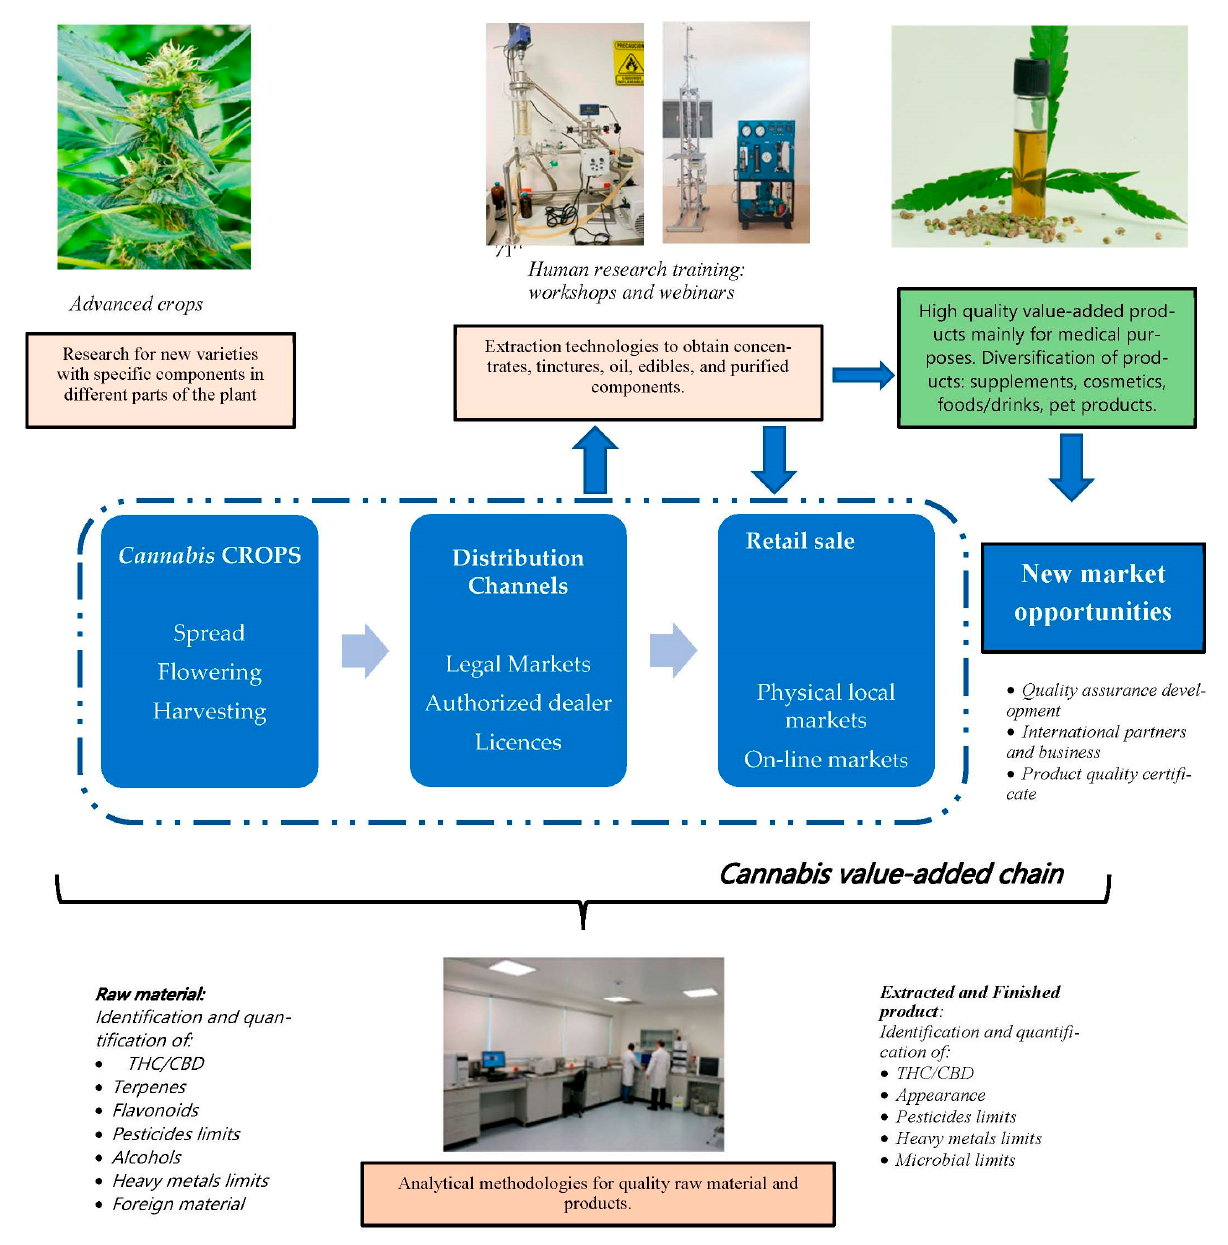
Figure 6. Perspectives on Cannabis value-added chain in Latin America include research on extractions techniques for cannabinoids to obtain diversi fi cation of high-quality products.